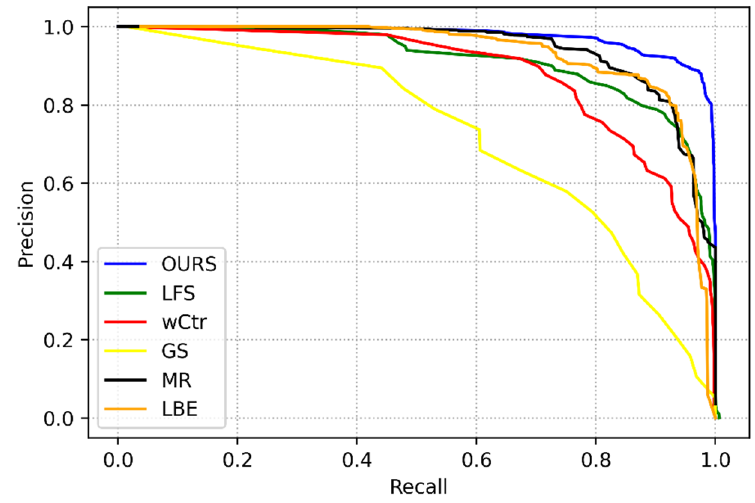
Figure 3. Precision–recall curves of our proposed method and other salient object detections in the light field datasets.